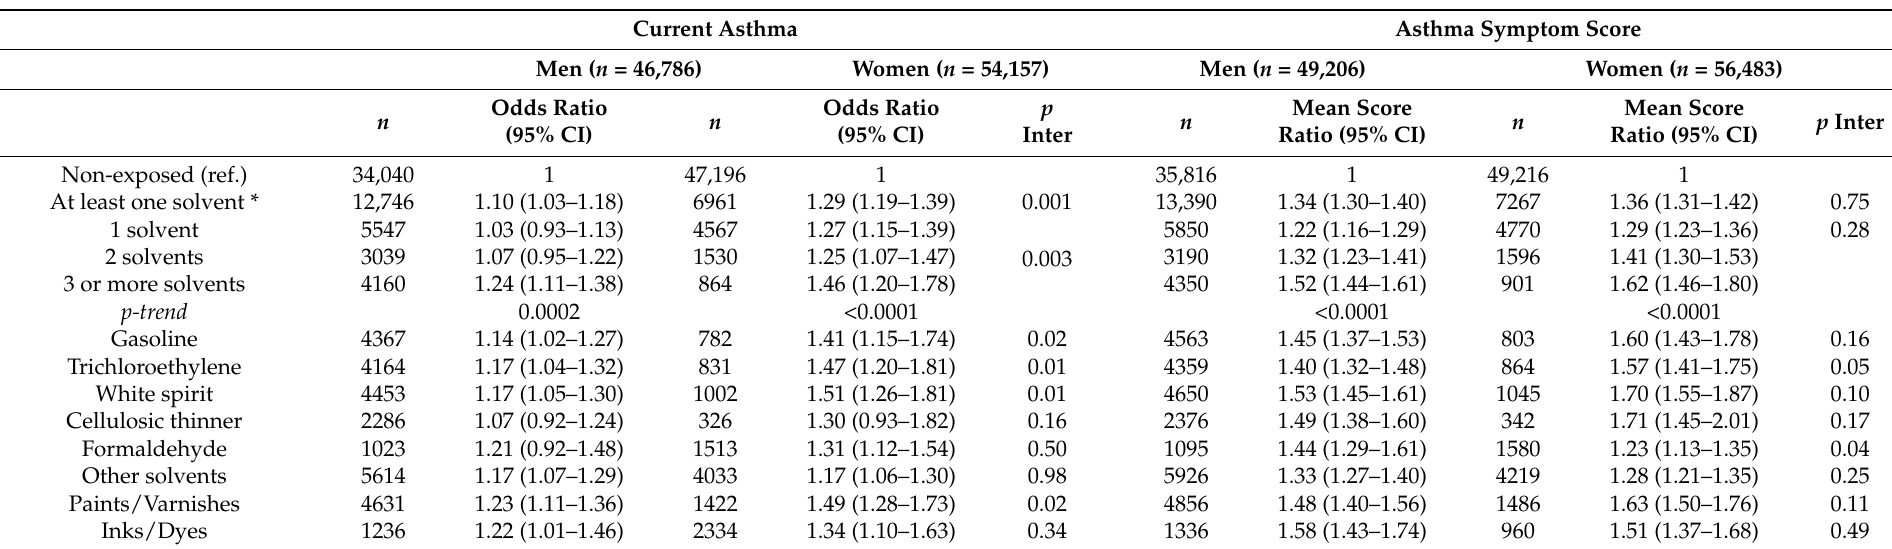
Table 2. Association between self-reported lifetime occupational exposures to solvents and current asthma or asthma symptom